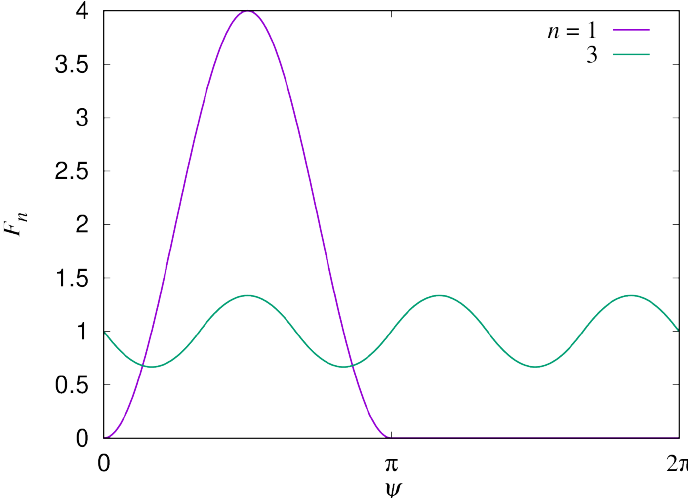
Figure 3. Modulation function F n ( ψ ) of the rotor torque on the azimuthal angle of the blade. The curves n = 1 and n = 3 plot the modulation for a single blade and a summation over three blades, respectively. The average of F n ( ψ ) over ψ is taken to be